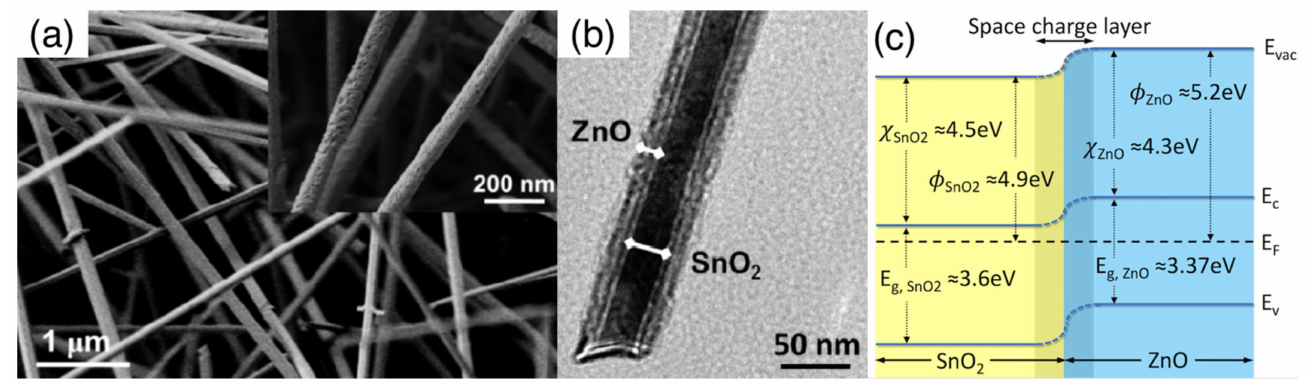
Figure 7. SEM ( a ) and TEM ( b ) images of SnO 2 -ZnO core–shell composite material and the schematic representation of the band structure for the SnO 2 -ZnO system ( c ). For both materials, the bulk values of their energy gap (E g ), work function ( φ ), electron affinity ( χ ) are reported; profiles of the vacuum (E vac ), valence band (E v ), conduction band (E c ) and Fermi level (E F ) energies are also schematically reported. Figure 7a,b are reprinted from